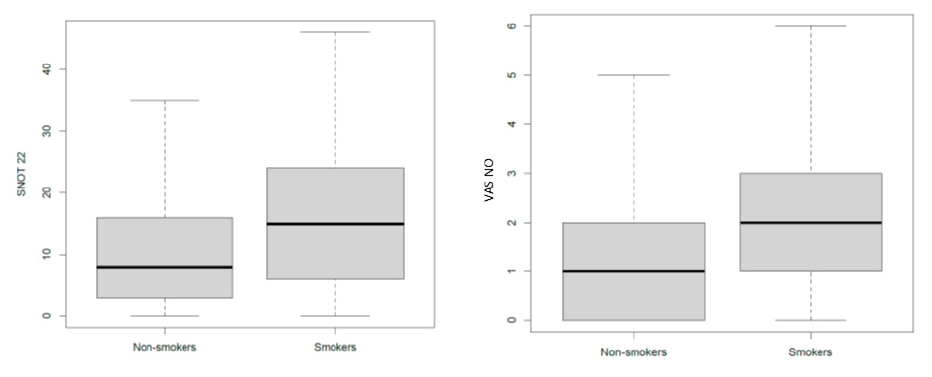
Figure 4. Nasal symptoms in smokers and non-smokers. SNOT-22: Sino-Nasal Outcome-22 Test; VAS NO: Visual Analog Scale for nasal obstruction. Table 5. Main study results.